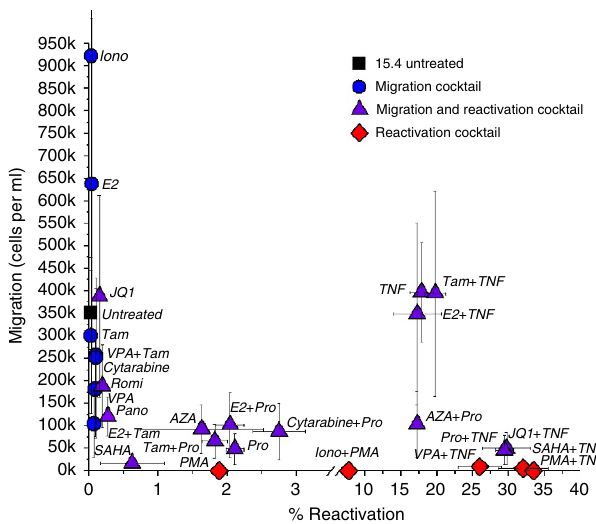
Figure 5 | Drug cocktails differentially control migration and reactivation of latently infected T-cells. Drug cocktail treatments control latently infected cell populations between states of migration (blue circles), migration and reactivation (purple triangles) or only reactivation (red diamonds). JLat 15.4 treated for 48h with leading HIV reactivation cocktails maps diverse migration and reactivation behaviours. Migration and reactivation values represent an average of duplicate or triplicate experiments. AZA, 5-Aza-2-deoxycytidine; E2, 17 b -Estradiol;